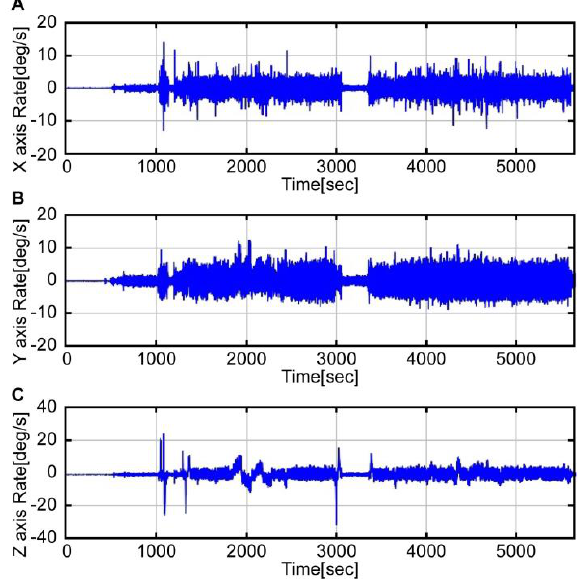
Figure 5. X, Y, Z rate by the MEMS gyroscope.